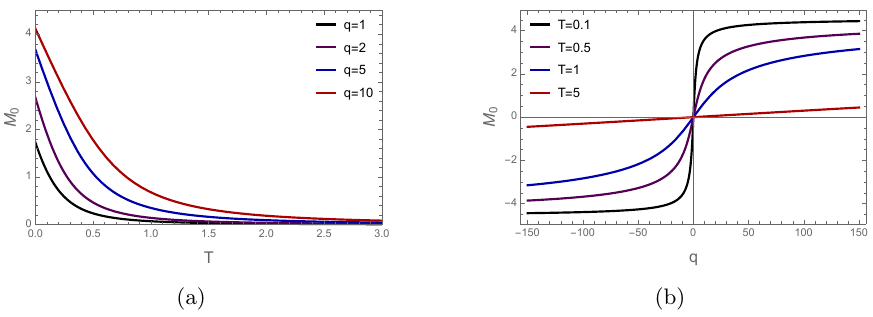
Figure 23 . (a) Temperature dependence of M 0 with for di(cid:11)erent density. (b) Density dependence of M 0 with di(cid:11)erent temperature. In both case, we set q (cid:31) = 1, (cid:11) = 0 and (cid:21) =